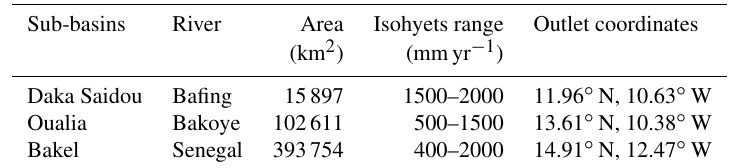
Table 1. List of the SRB sub-basins. Superficies have been calculated with the GRASS-3.4 model and 1arc sec SRTM elevation data. Indicative isohyets ranging are extracted from Faye et al. (2015).